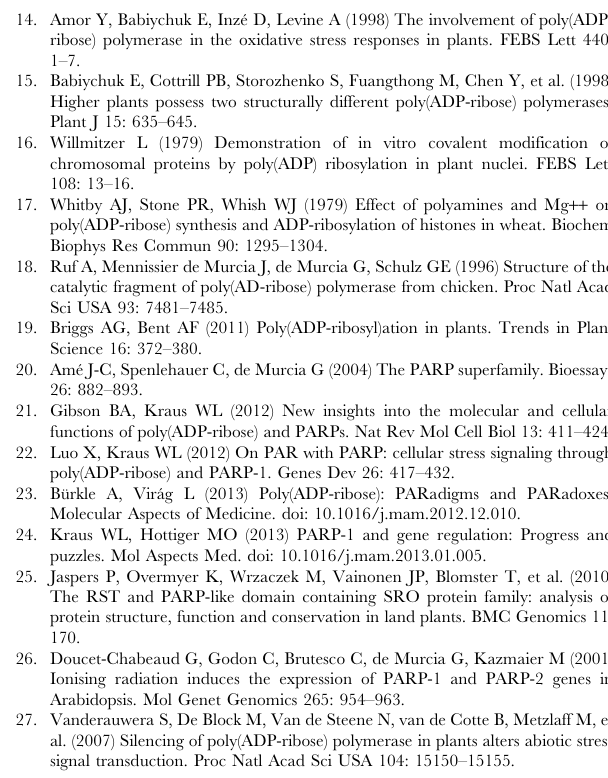
seedlings were subjected to PARP inhibiting ( + ) or control ( 2 ) conditions is indicated. Figure S3 PARP inhibition and photosynthesis. The, photosynthetic yield (Y_II) (A), non-photochemcial quenching (NPQ) (B) and ETR (Electron transport rate) (C) is presented of Arabidopsis seedlings grown either for eight days in control ( 2 3MB) or in treatment ( + 3MB) conditions. 8–18 seedlings were analyzed in each of the four independent experiments (n =42). A significant difference (P , 0.05) between the conditions is indicated by an asterisk. Figure S4 PARP inhibition is not changing starch accumulation. Representative pictures of Arabidopsis seedlings stained with iodine solution day1, day2 or day7 after transfer to either 3MB containing (A) or control plates (B). Table S1 Overview of differentially expressed genes. The transcription profiles of Arabidopsis leaf two were analyzed via AGRONOMICS1 microarrays at the indicated time points of leaves 2 from seedlings transferred after 7 days of growth on control media either to control or PARP inhibitor containing media. Shown are all genes with changes in gene expression with the direction of change at the different time points relative to the ( 2 3MB) control. Samples comprised of pools of 50 leaves taken from 10 plants of each of the five replicates within a single experiment, this was repeated in three independent experiments (n =3). Direction of change is indicated by red - induction and blue – repression, genes which changed the time point before are marked in bold.